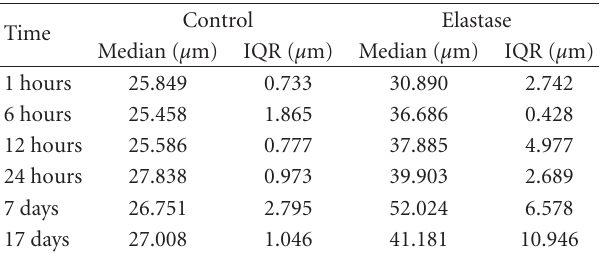
Figure 8: Cross-validation accuracy plot for the selection of the optimal work parameters of the micro-CT classifier ( Υ = 10 − 4 , P = 10 8 ). Table 3: Evolution of D 0 at the experiment time points after elastase aspiration.